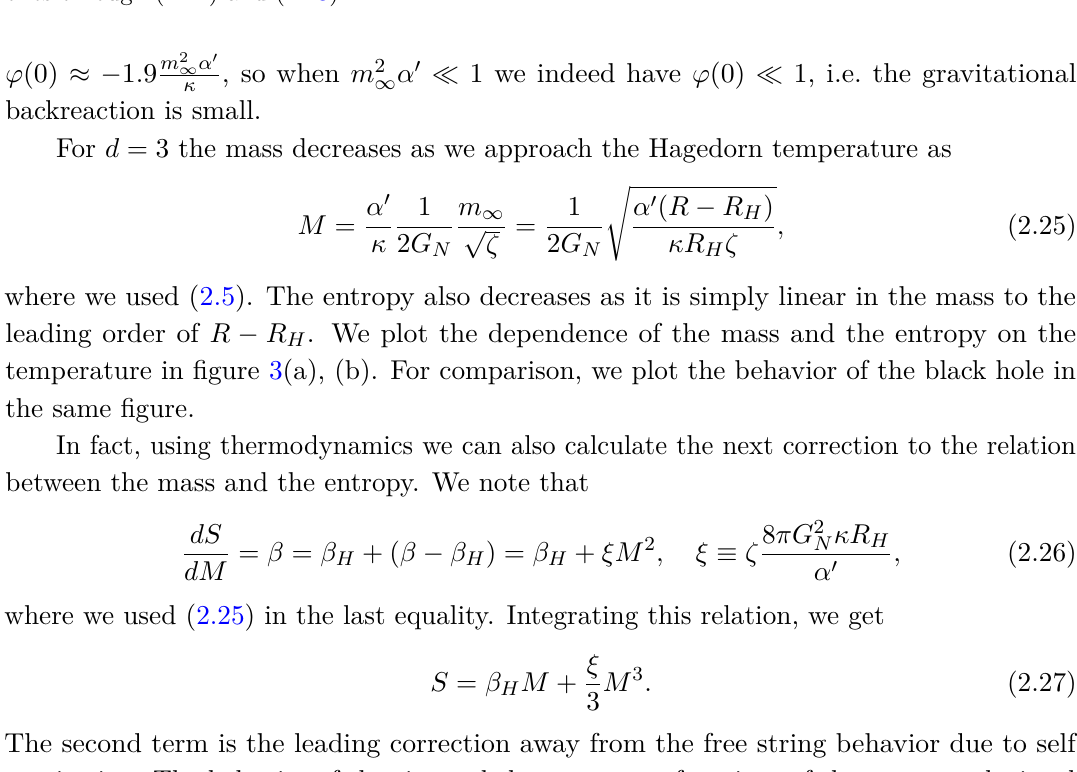
Figure 2 . Solution for d = 3 . (a) Plot of the rescaled profile ˆ χ (ˆ ρ ) . (b) Plot of the rescaled gravitational potential ˆ ϕ (ˆ ρ ) ≡ − R d 3 ˆ y | ˆ χ (ˆ y ) | 2 . The true values of χ and ϕ are related to the rescaled | ˆ x − ˆ y | ones through (2.11) and